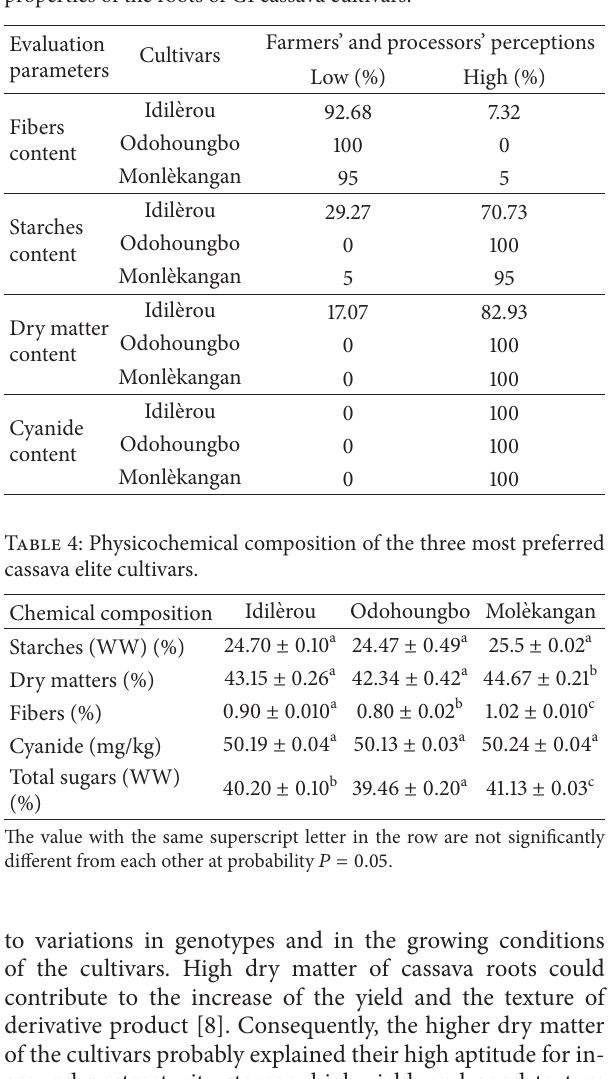
Table 3: Farmers and processors perceptions on physicochemical properties of the roots of G1 cassava cultivars.